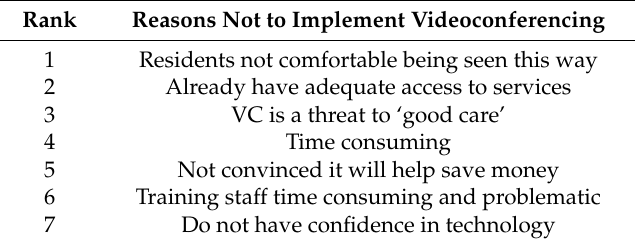
Table 6. Reasons for reluctance to implement videoconferencing (ranked most to least important). Rank Reasons Not to Implement